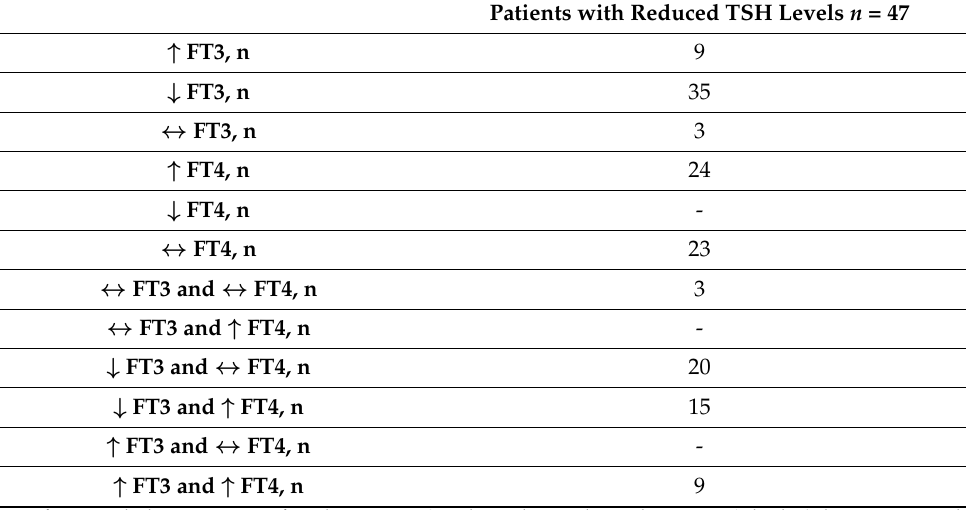
Table 2. Distribution of thyroid hormone levels in patients with reduced TSH levels.